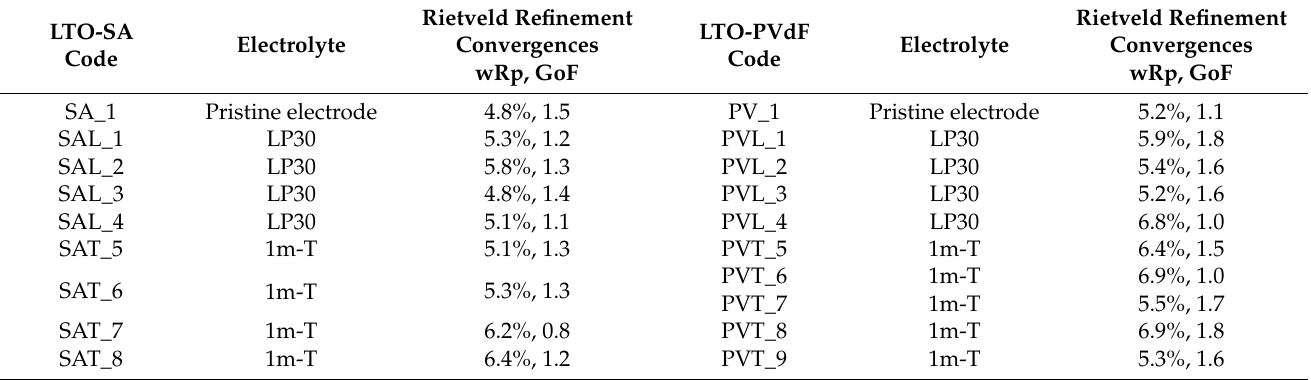
Table 1. LTO-based electrodes tested at ELETTRA synchrotron MCX beamline and refinement convergences.